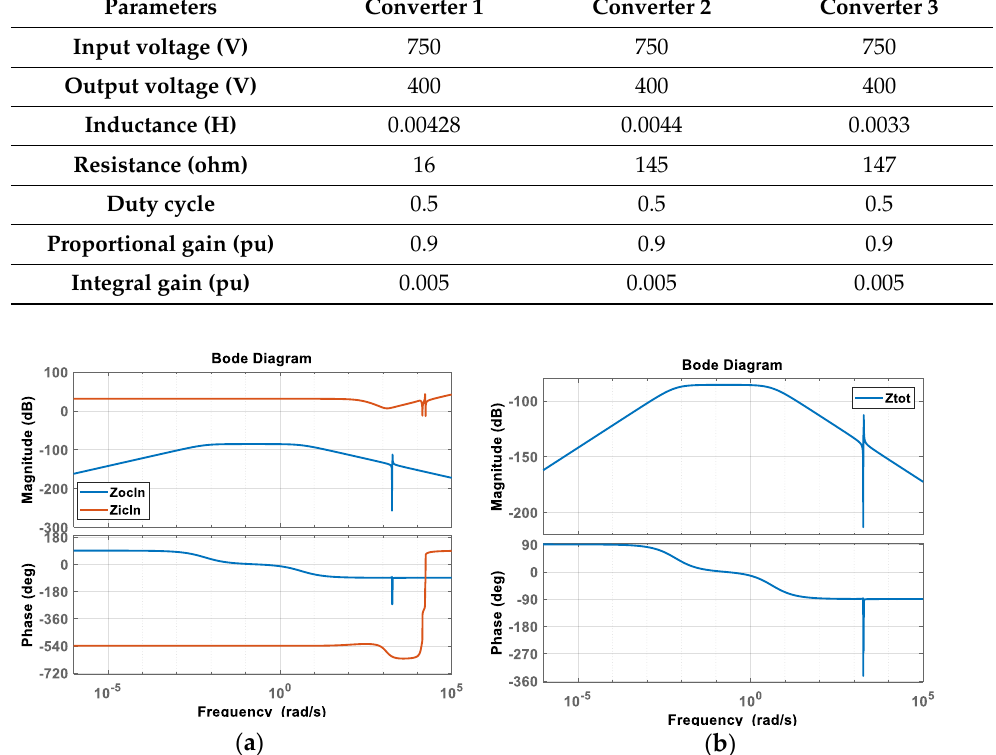
Figure 3. Frequency response of the system: ( a ) Output and input impedance; ( b ) total impedance seen from DC link.